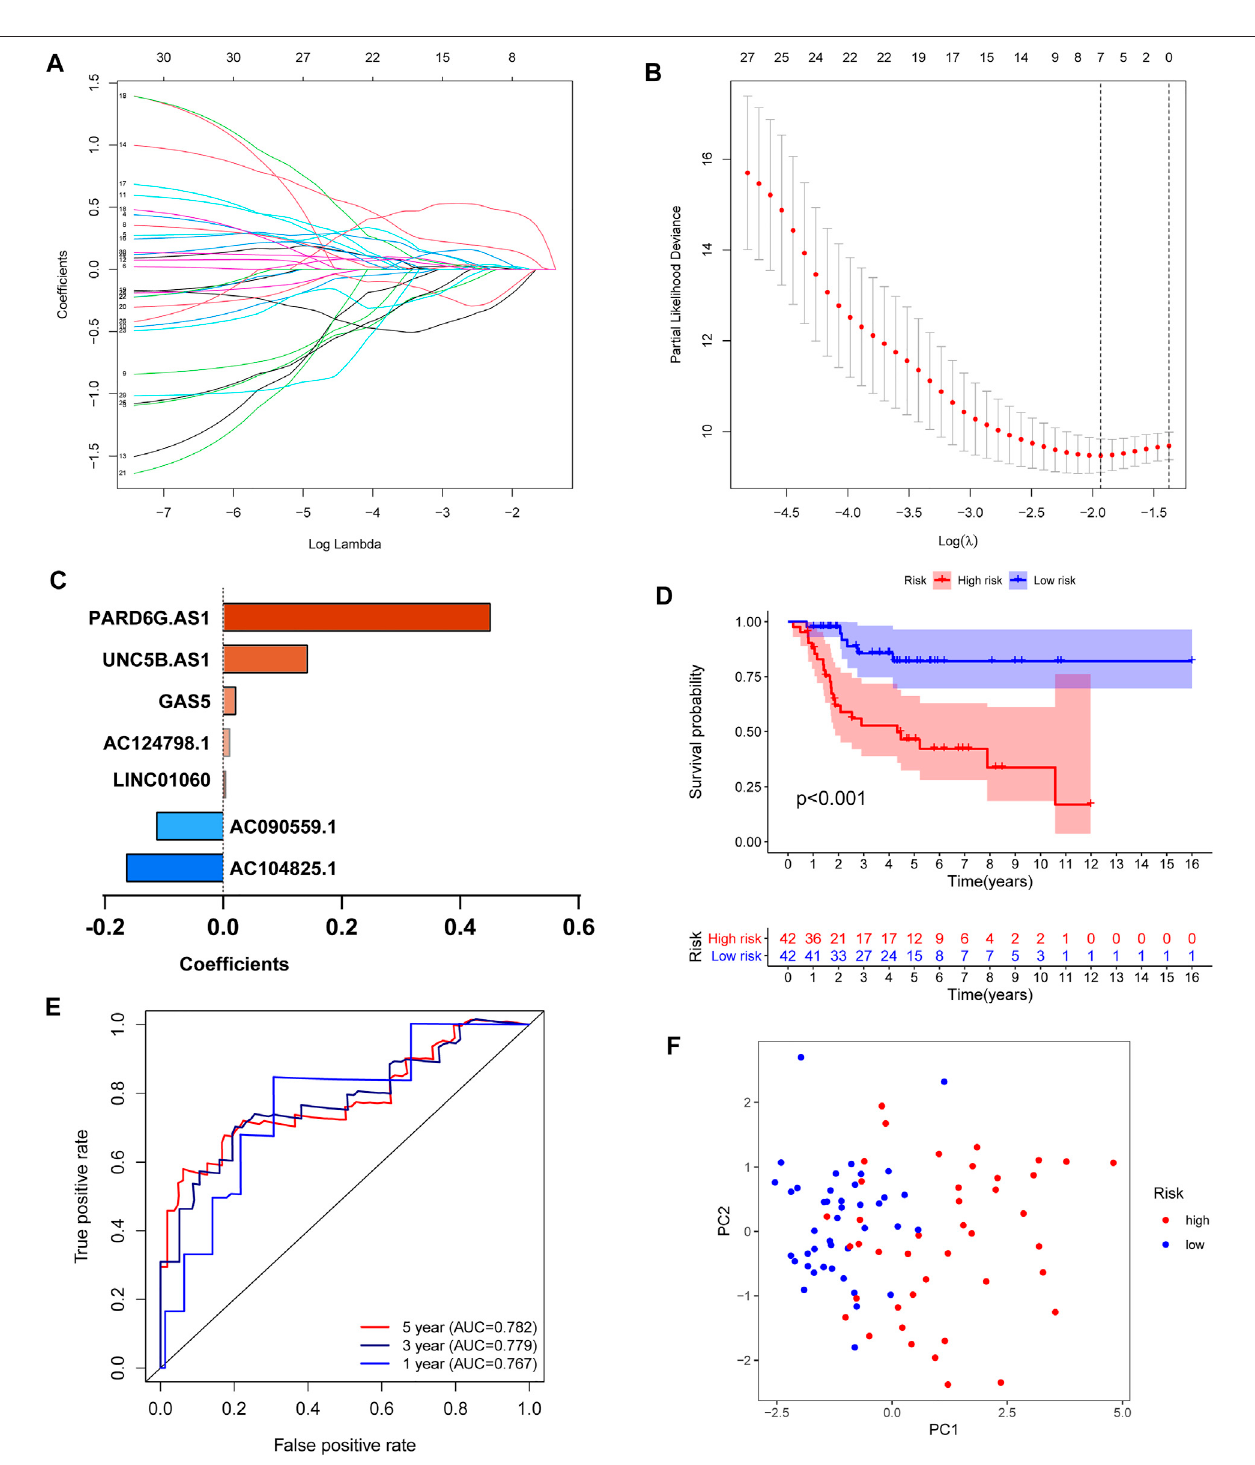
FIGURE 4 | Construction of an iron metabolism-related lncRNA signature. (A,B) LASSO Cox regression analysis showed that seven iron metabolism-related lncRNAs were good candidates for constructing the prognostic signature ( λ = 0.0125, obtained seven nonzero coef fi cients). (C) Coef fi cients of the seven iron metabolism-related lncRNAs. (D) Kaplan – Meier curves of patients in the high- and low-risk groups. (E) ROC curve to evaluate the 1/3/5-year prediction ef fi ciency of the iron metabolism-related lncRNA signature. (F) Principal component analysis (PCA) based on the identi fi ed iron metabolism-related lncRNA signature.